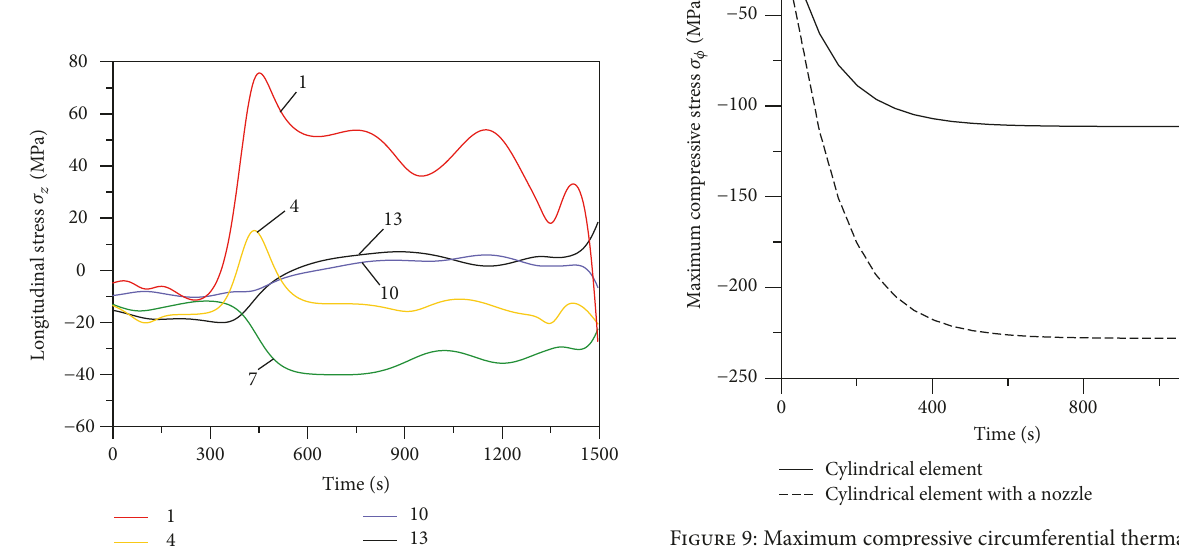
Figure 6: Circumferential thermal stress transients in seven points on the outlet header inner surface.